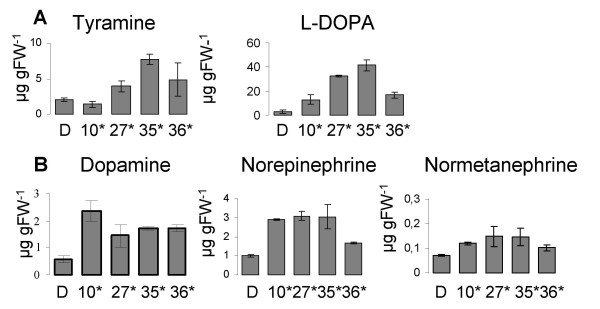
Catechoalmines analysis. GC-MS analysis of HD1 plants revealed changes in catecholamine levels. Concentration of catecholamine's precursors, tyramine and L-DOPA, is elevated as well. Results are mean ± SE of four independent measurements on three individual plants per line. Asterisks (*) indicate values that are significantly different from the wild type plants.